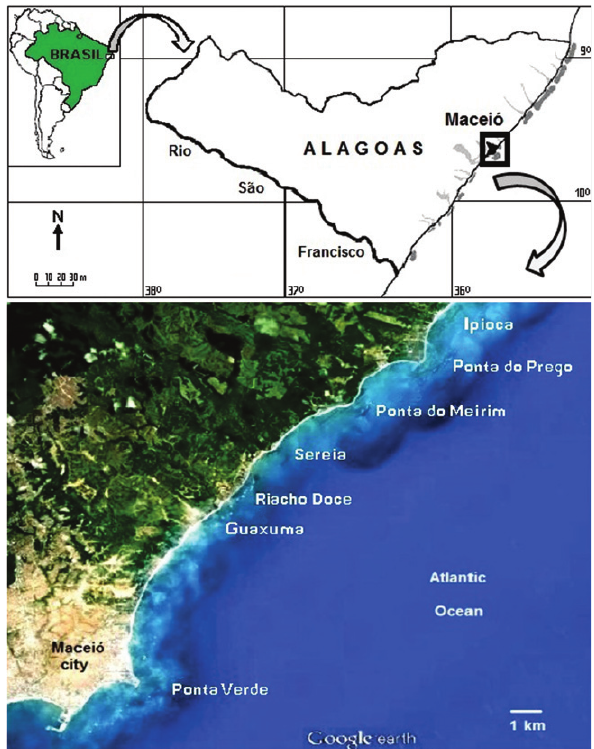
Figure 1. Map of the Alagoas state in northeastern Brazilian and, the coast of the Maceió with the location of reef ecosystems